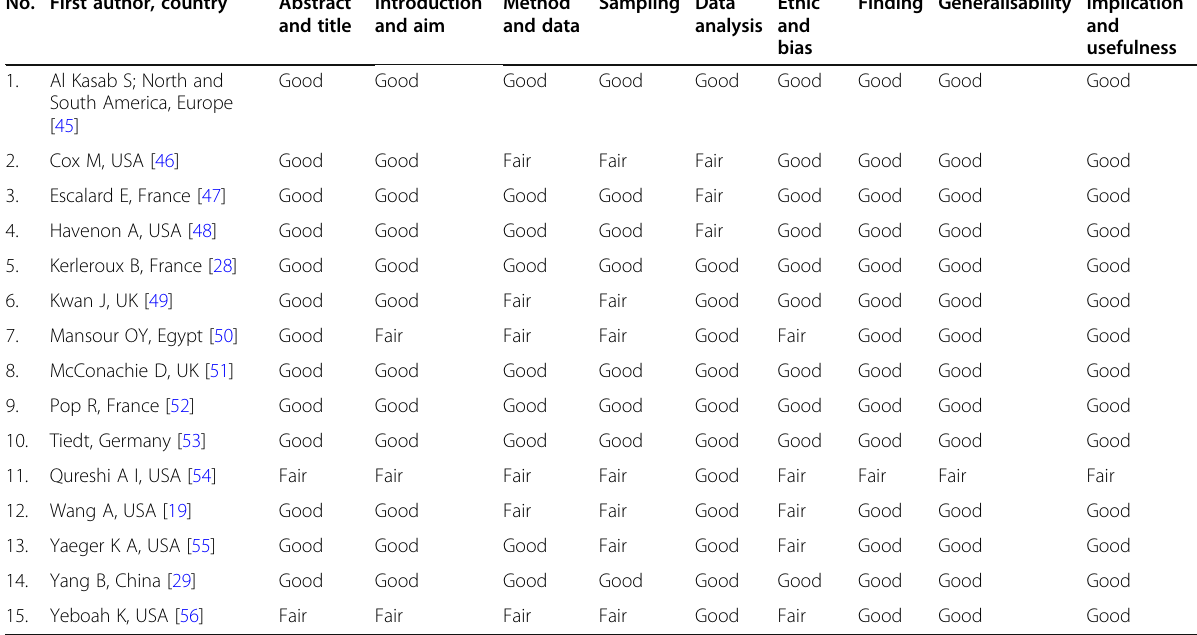
Table 1 Quality assessment and risk of bias by Hawker and colleagues